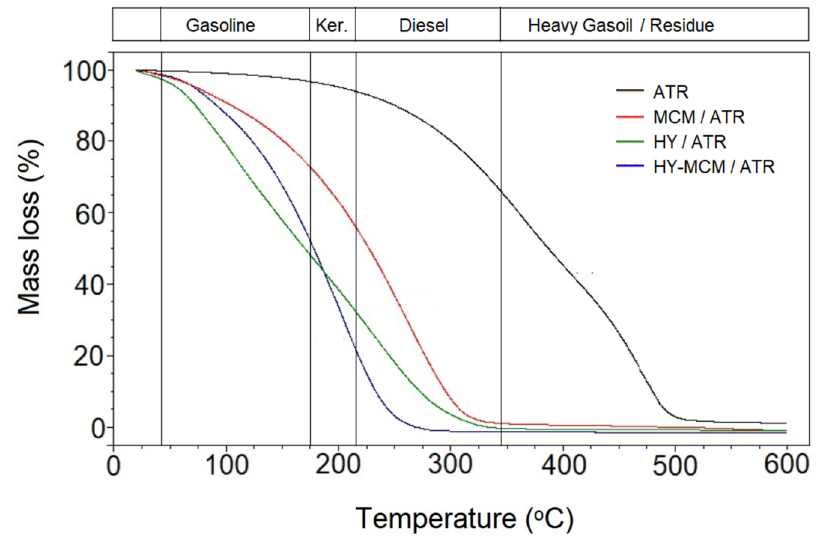
Figure 6. TG curves for ATR samples without catalyst; and ATR in the presence of porous materials, showing the temperature ranges for hydrocarbons.